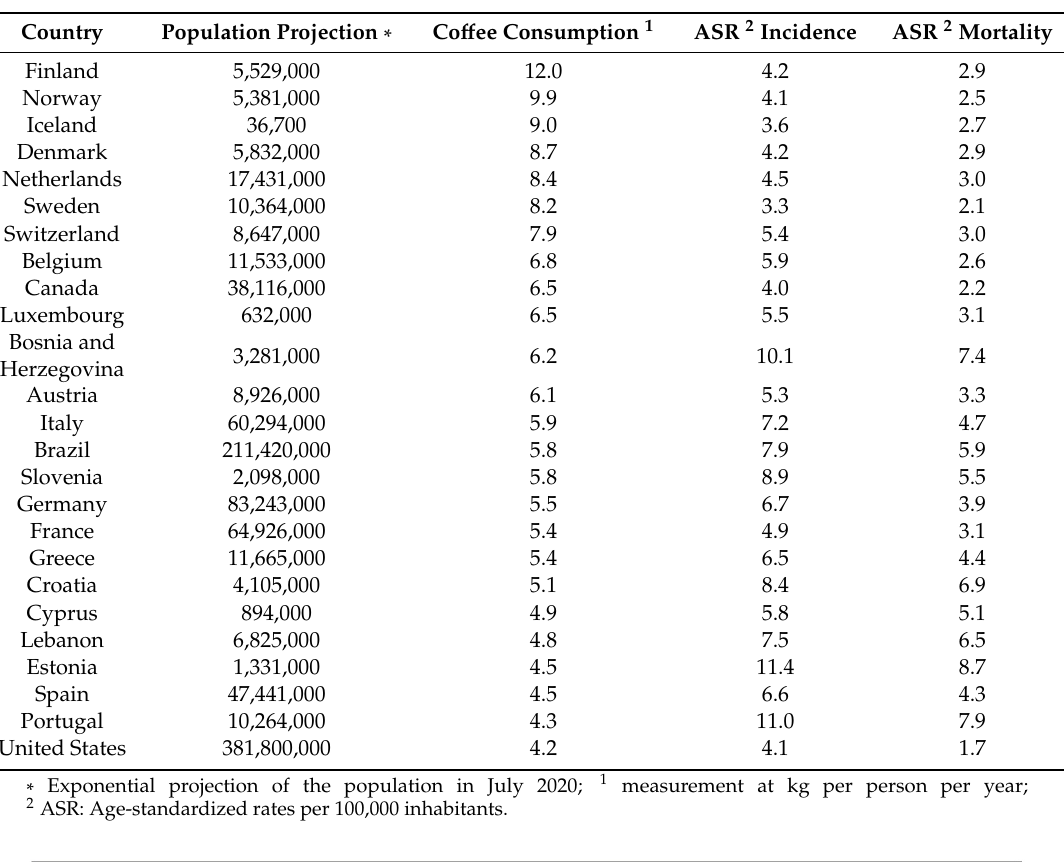
Table 1. Co ff ee consumption and the incidence / mortality by stomach cancer by country. It shows in descending order the co ff ee consumption by country and the estimated incidence / mortality of stomach cancer in 2018.